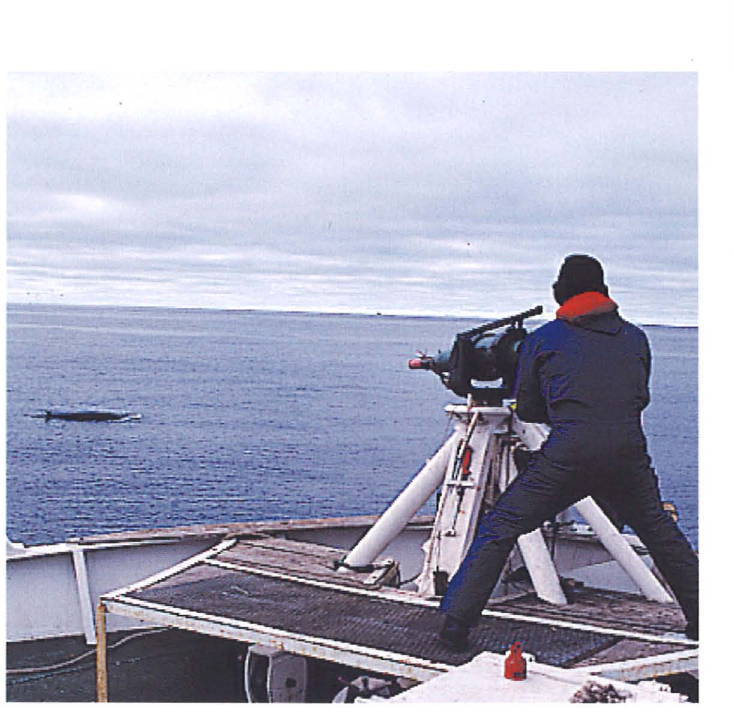
Minke whales are hunted in the Barents